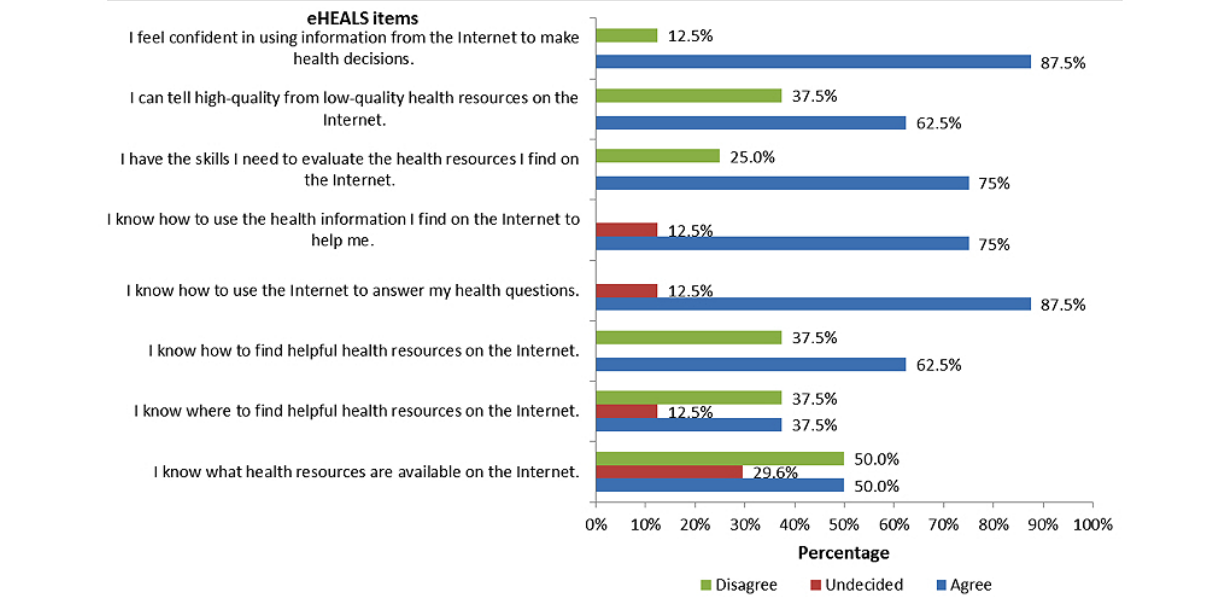
Figure 2. Participant responses to the eHEALS items